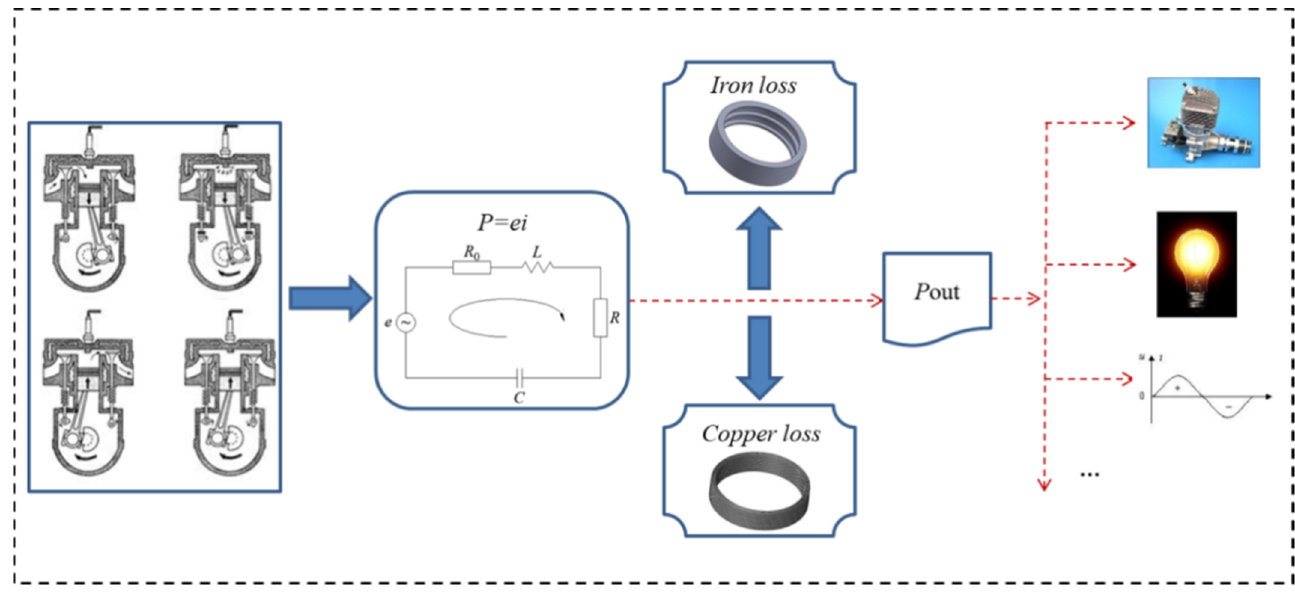
Figure 4. Energy transfer roadmap.